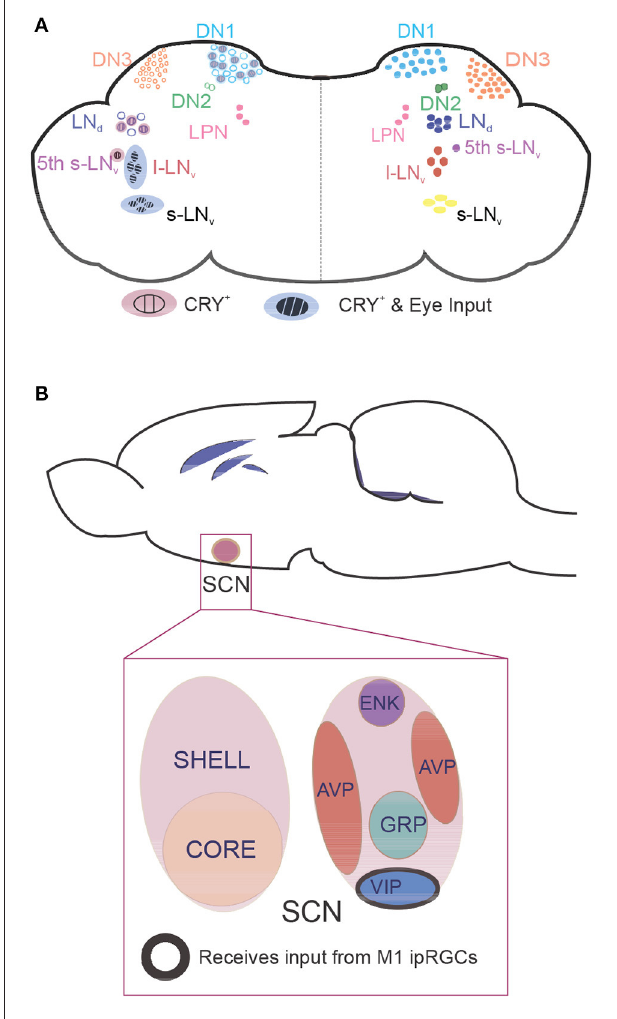
FIGURE 2 | Location of clock neurons in fly and mouse brains. Neurons that express core clock proteins localize in specific regions of the cortex. (A) In flies, ∼ 150 clock neurons can be generally categorized as dorsal neurons (DNs) or lateral neurons (LNs). The right hemisphere contains clock neuron populations, and the left hemisphere shows whether these neurons receive retinal input and/or are intrinsically photosensitive due to CRY expression. (B) In mammals, core clock neurons are found in the suprachiasmatic nucleus (SCN). Neurons in the photosensitive SCN core primarily express the neuropeptides vasoactive intestinal polypeptide (VIP) and gastrin-releasing peptide (GRP), whereas neurons in the SCN shell express arginine vasopressin (AVP) and enkephalin (ENK). M1 intrinsically photosensitive retinal ganglion cells innervate VIP neurons to pass photic information that synchronizes the clock. CRY, cryptochrome; l-LNv, large ventrolateral neuron; LNd, dorsal lateral neuron; LPN, lateral posterior neuron; s-LNv, small ventrolateral